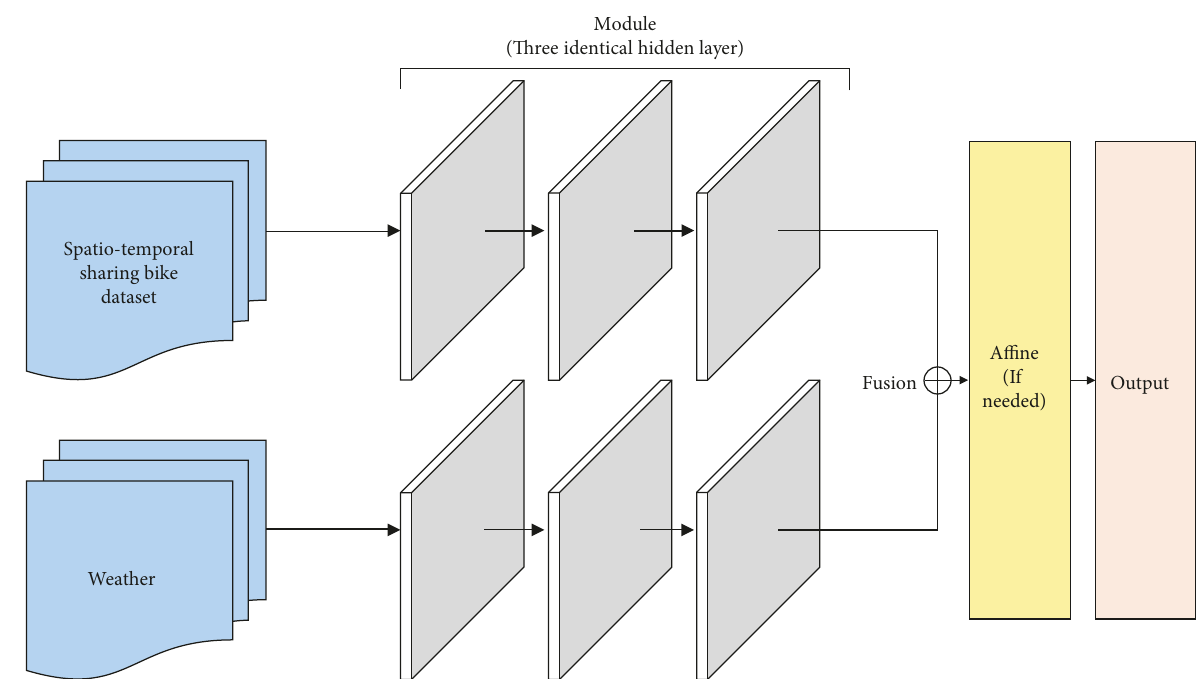
Figure 1: Proposed framework for prediction of bike-sharing